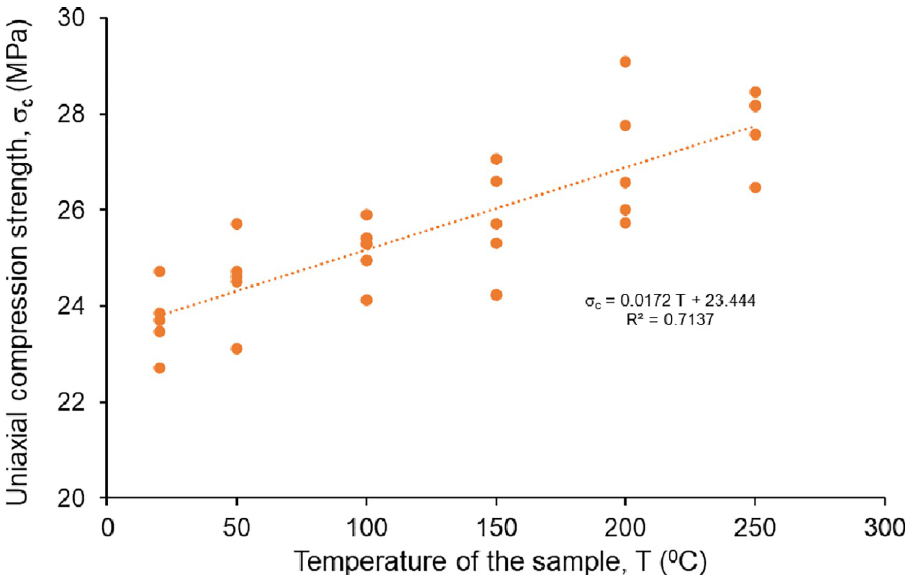
Fig 7. The variation of the σ c of the rock salt at different temperatures.